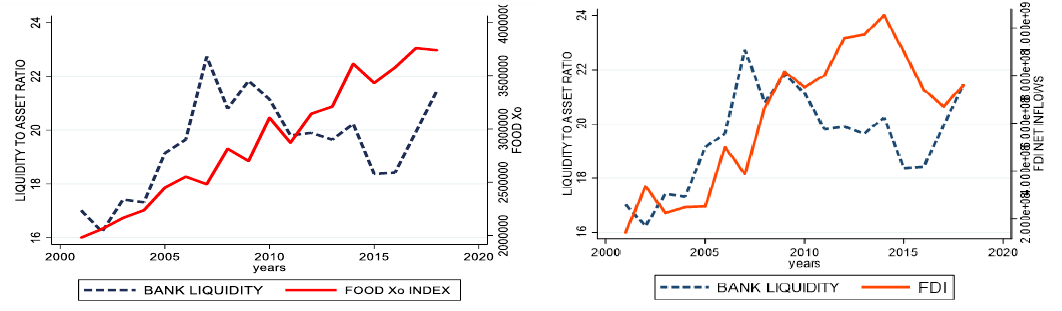
Figure 5: Bank Liquidity Ratio Vs. Food Production. Figure 6: Bank Liquidity Ratio Vs. FDI Net Inflows Figure 5: This figure presents the inverse movement between bank liquidity and the food production index in Africa since 2000.